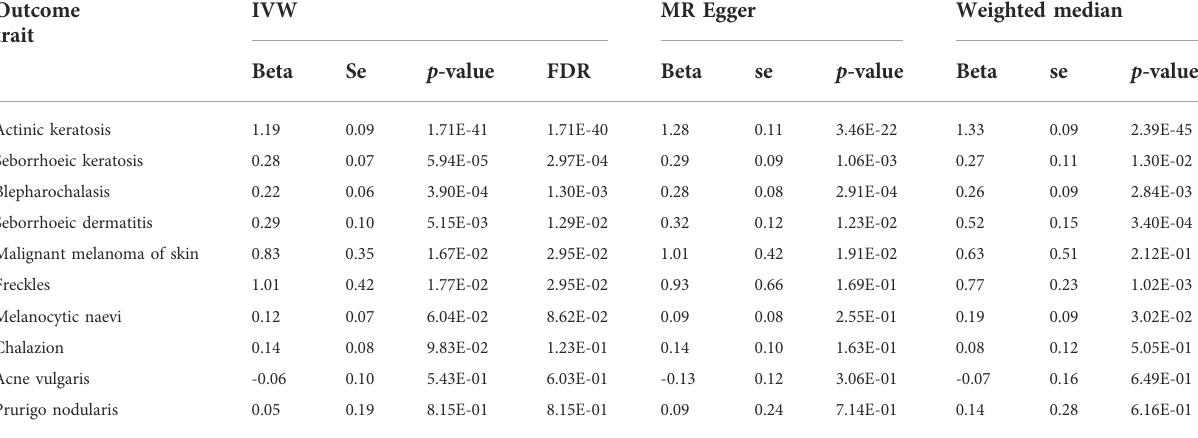
TABLE 2 MR results between tanning response to sun exposure and ten skin diseases in the discovery study.